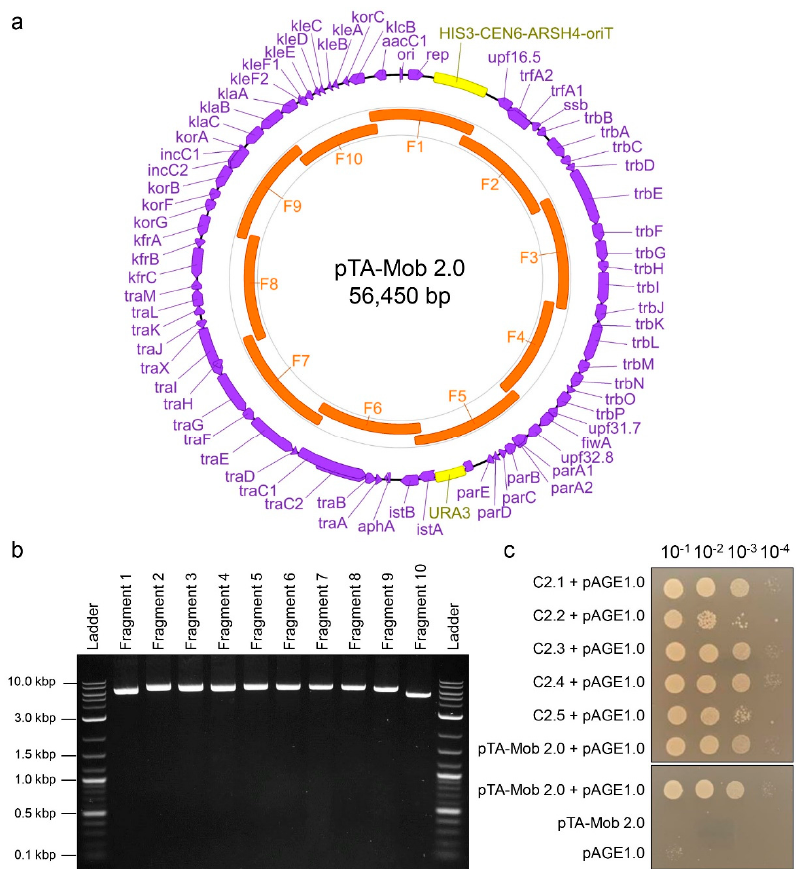
Figure 1. Optimized PCR-based synthesis of plasmid pTA-Mob 2.0: ( a ) Plasmid map of pTA-Mob 2.0 with coding regions (CDS) annotated in purple, and inserted regions (yeast elements and origin of transfer as described in this paper) in yellow. Regions highlighted in orange indicate the 10 overlapping fragments used in optimized assembly. CDS annotations were transferred from the Birmingham IncP-alpha isolate RK2 [36] and then individually confirmed via BLAST against the NCBI non-redundant protein sequences database (BLASTx). The figure was generated using Geneious version 2019.2, created by Biomatters. ( b ) Agarose gel electrophoresis of pTA-Mob 2.0 amplified as ten overlapping fragments and ( c ) partial conjugation results of newly assembled pTA-Mob 2.0 plasmids (colonies C2.1 to C2.5) to recipient E. coli containing the pAGE1.0 plasmid. As a positive control, we used parental pTA-Mob 2.0 conjugating to pAGE1.0, and as negative controls we used donor pTA-Mob 2.0 or recipient pAGE1.0